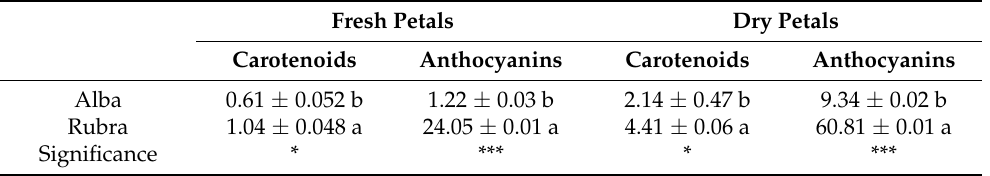
Table 3. Total carotenoid (mg/g) and anthocyanin (mg/100 g) content in fresh and dry petals from Rosa rugosa cv. Alba and cv. Rubra.